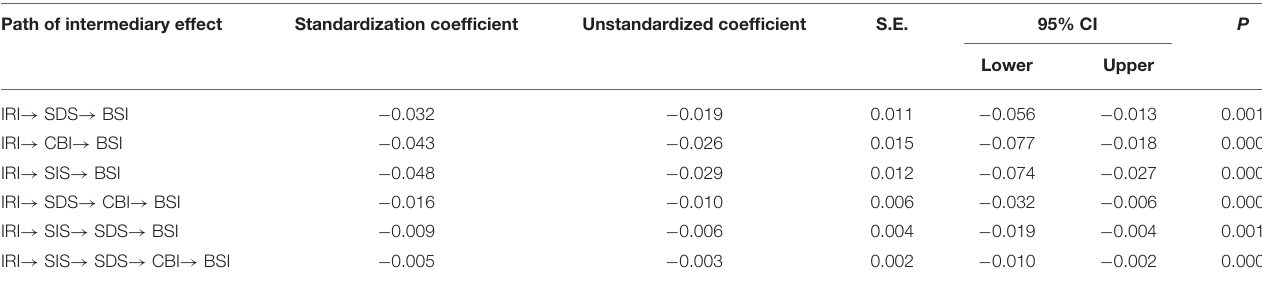
TABLE 5 | Mediation effect of patients’ self-efficacy (CBI), depression symptoms (SDS), and stigma (SIS) in the effect of social workers’ empathy ability (IRI) on patients’ suicide ideation (BSI) at T2. Path of intermediary